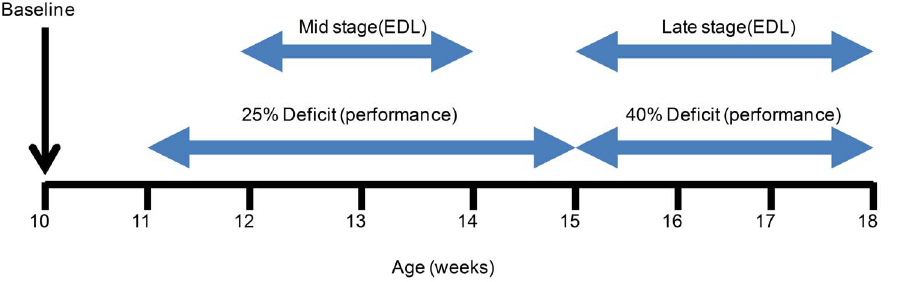
Figure 1. Timeline of performance assays and insitu EDL muscle force assessment as a function of B6SJL-SOD1 G93A mouse age. The mid-stage assessment of EDL in situ force measurements correlated with the timing of performance assays at a 25% forelimb grip strength deficit. Late stage assessment correlated with the timing of performance assays at 40% forelimb grip strength deficit. Unrestrained whole body plethysmography (uWBP) was performed after each surviving animal completed the final performance assays at approximately 18 weeks of